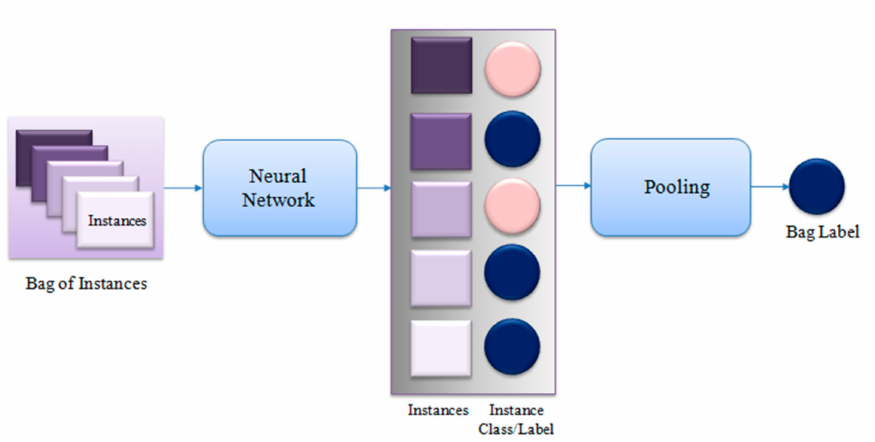
Figure 2. General pooling